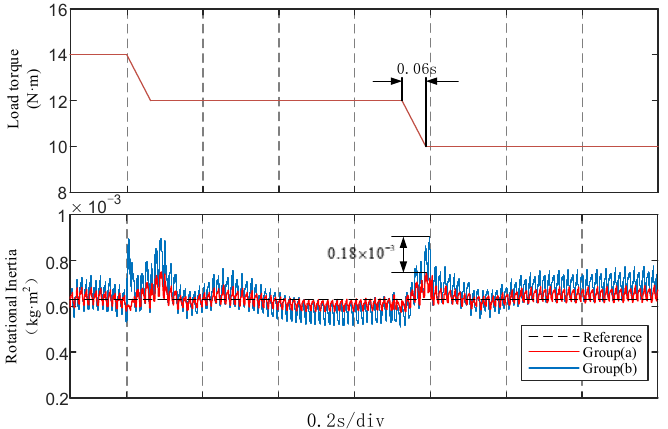
Figure 13. Identification results of Experiment (iii).